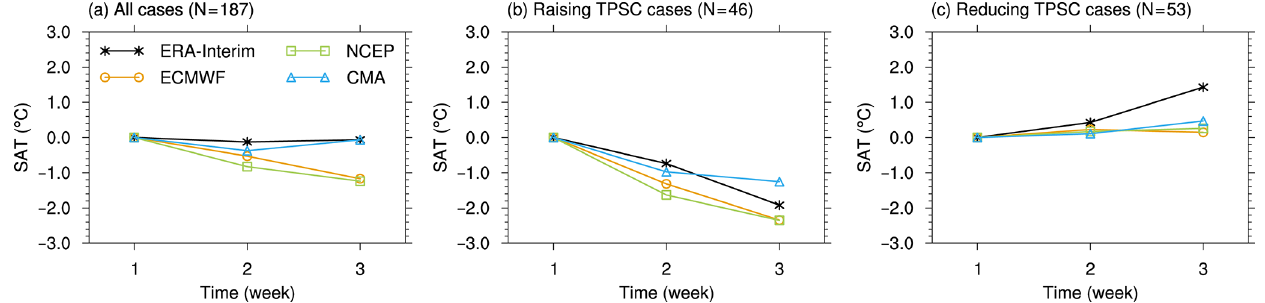
Figure 10. Composites of surface air temperature over the Tibetan Plateau (unit: ◦ C) for (a) all cases, (b) increasing TPSC cases and (c) decreasing TPSC cases. Black lines, orange lines, green lines, blue lines and black lines represent composites in observation, ECMWF, NCEP and CMA, respectively; see legend in (a) . The x axis represents the number of weeks in the cases for the composites, which are also forecast lead times (unit: week). The “N” in the title of each plot indicates the number of cases for the